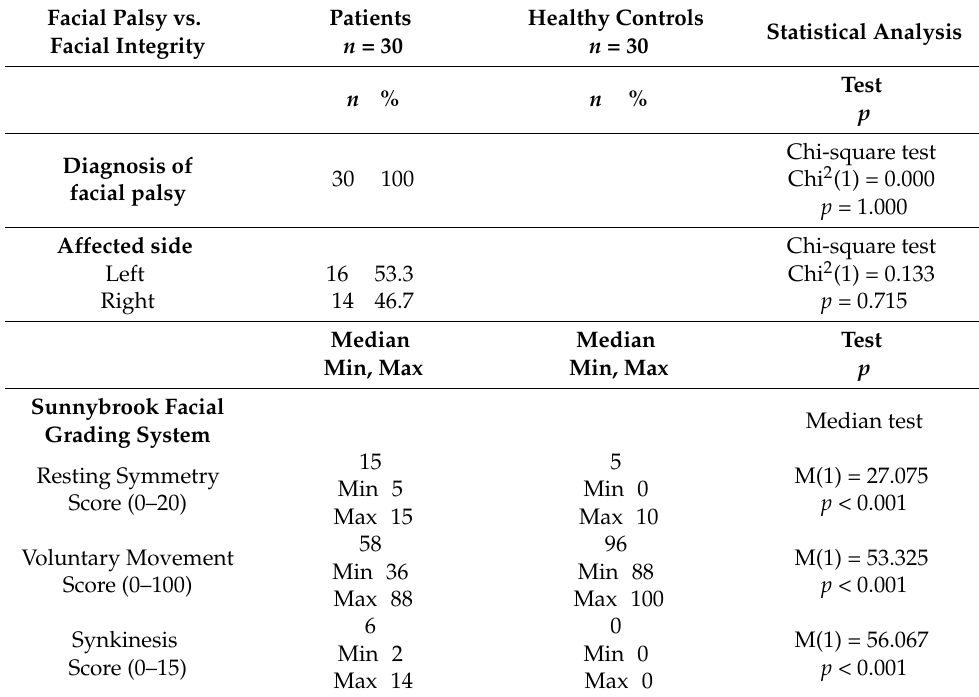
Table A2. Information on facial palsy and facial integrity. Facial Palsy